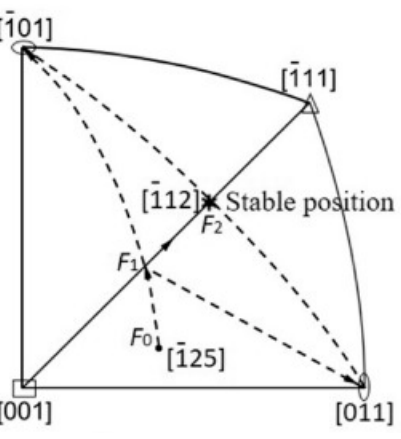
Figure 3. The theoretical rotation behavior of an FCC single crystal specimen under uniaxial tension sion [27]. The tensile axis starts from F 0 , rotates to F 1 following the pathway of F 0 → F 1 → [27]. The tensile axis starts from F (cid:2868) , rotates to F (cid:2869) following the pathway of F (cid:2868) → F (cid:2869) → [1(cid:3364)01] and (cid:2) (cid:3) and then turns to 112 along the edge of the orientation then turns to [1(cid:3364)12] along the edge of the orientation triangle.